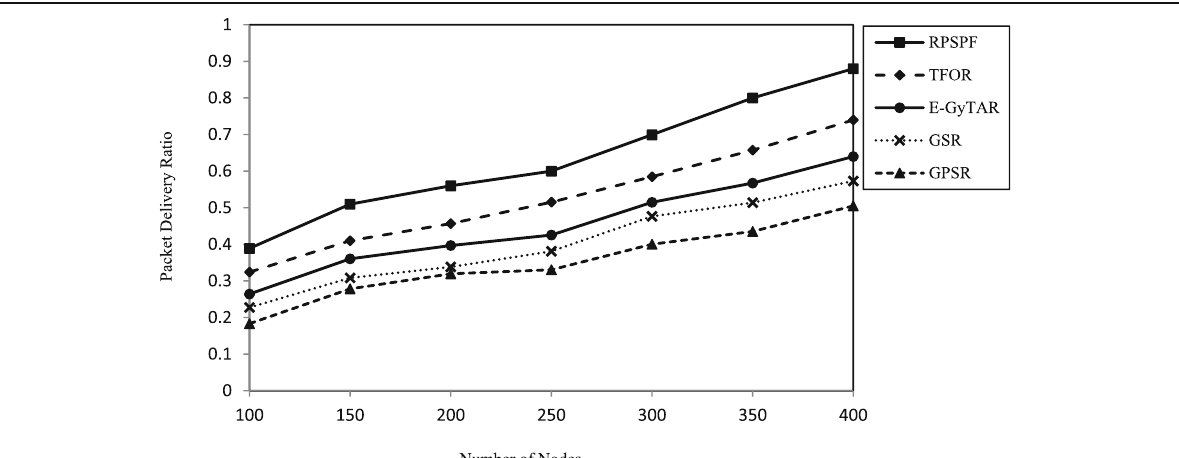
Fig. 5 Packet delivery ratio as a function of the number of nodes (@5 packets/s). RPSPF represents Reliable Path Selection and Packet Forwarding Routing Protocol which is proposed approach and is represented by a solid line with a square. TFOR is traffic flow-oriented routing protocol and is represented by a dashed line having rhombus. E-GyTAR is Enhanced Greedy Traffic Aware Routing protocol and is represented by a solid line with circle. GSR is geographic source routing protocol and is presented by a dotted line having a cross. GPSR is Greedy Perimeter Stateless Routing Protocol and is presented by a dashed line having a triangle